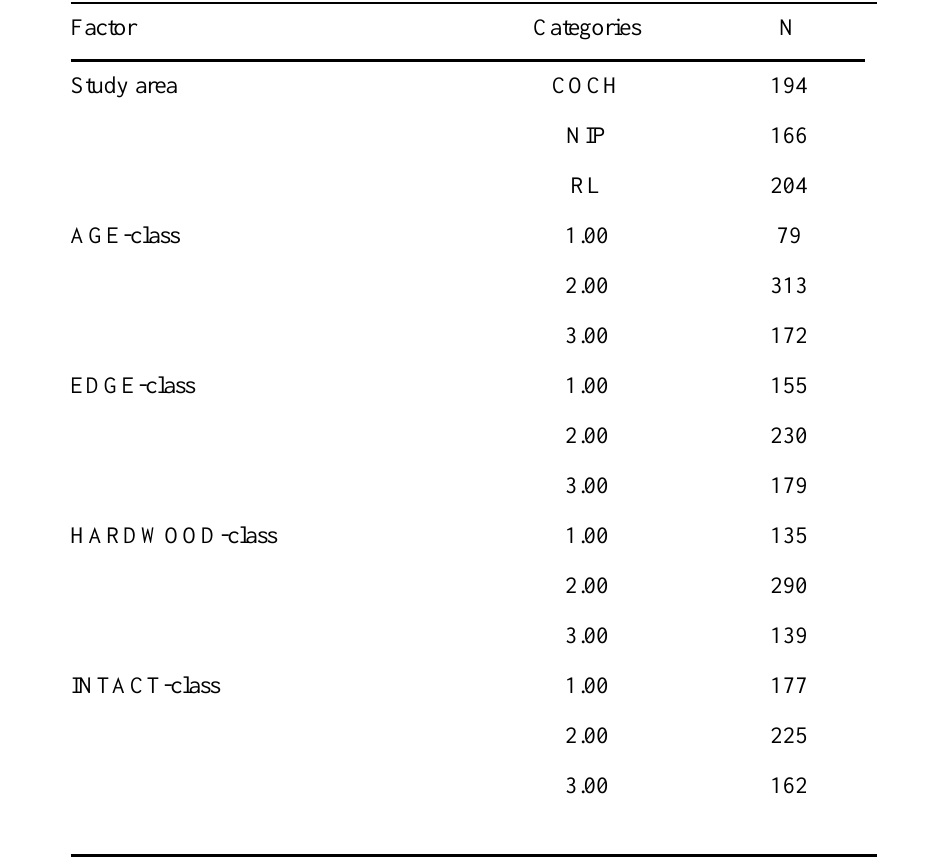
Table 3. Factorial sample design, with number of samples in each of the four factors, the between-subjects factors, and the randomized block (study